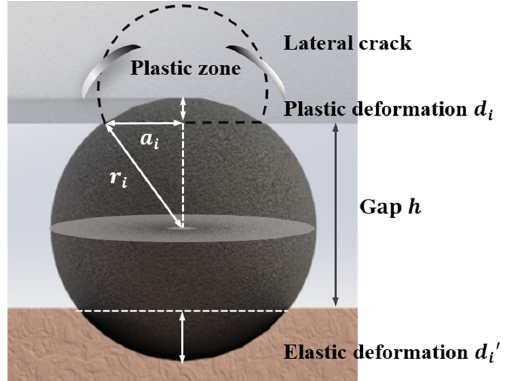
Figure 2. Schematic of plastic deformation and lateral cracks on the silicon workpiece by single abrasive at the pad–workpiece interface; di and di’ denote the workpiece plastic and pad elastic deformation depths, respectively, h is the gap between the pad and workpiece, a i is the contact area radius for the abrasive and workpiece, and 𝑟 (cid:3036) is the radius of the abrasive particle.